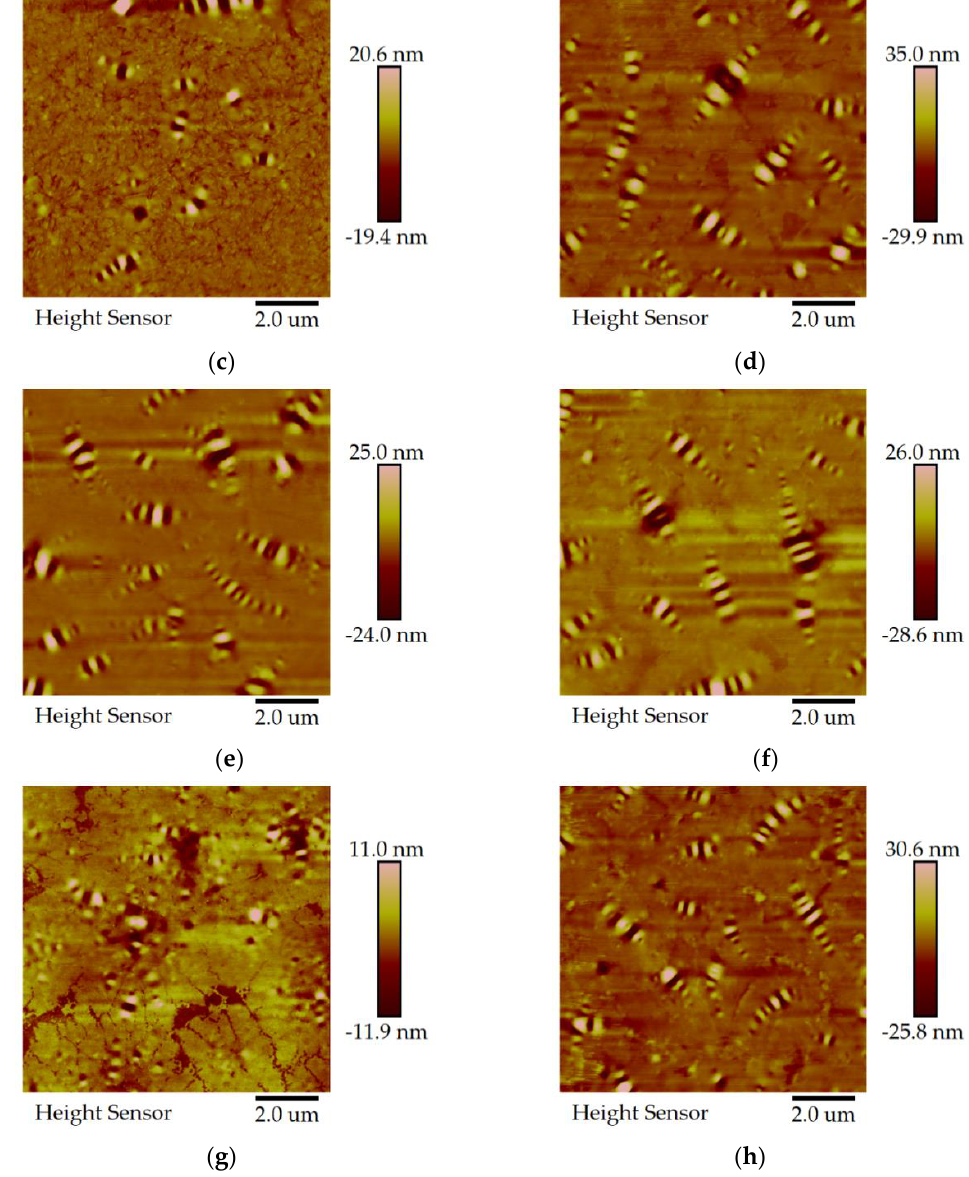
Figure 11. Microstructures obtained from AFM images of the asphalt-binders: ( a ) Virgin; ( b ) RTFO Residue; ( c ) PAV Residue; ( d ) 1st − RE I+6%; ( e ) 2nd − AG I+6%; ( f ) 2nd − RE I+10%; ( g ) 3rd − AG I+10%; ( h ) 3rd − RE I+14%.